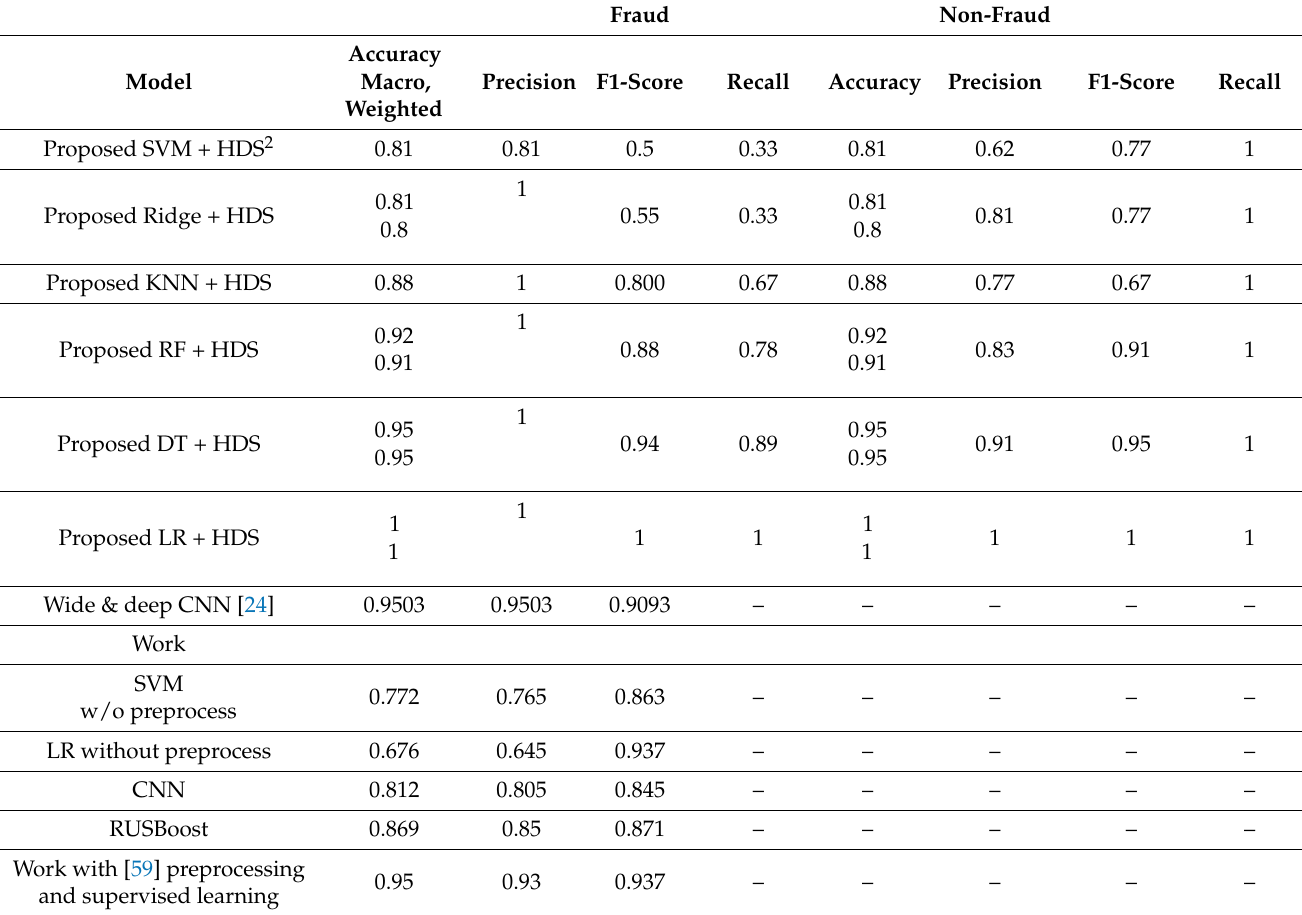
Table 1. Comparative results of various algorithms with expert knowledge preprocessors versus other